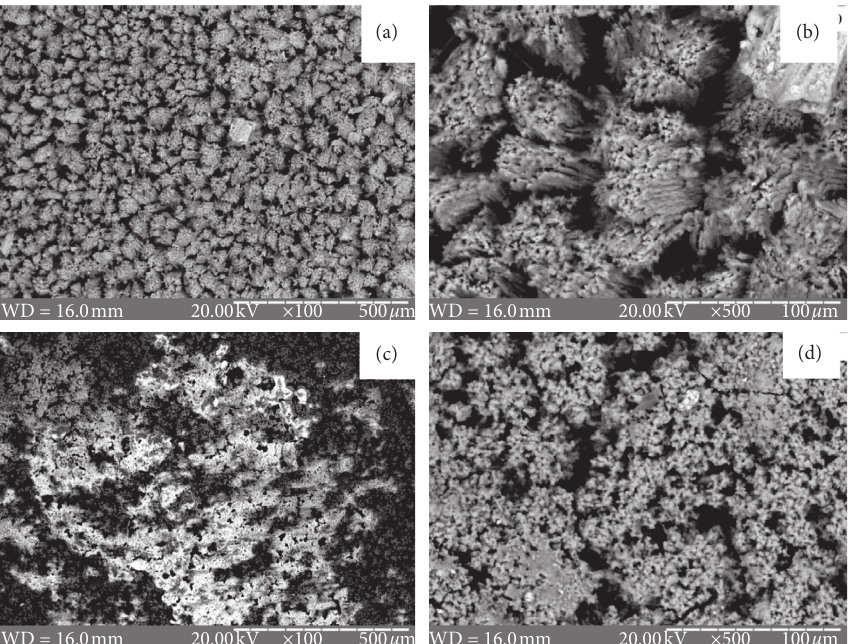
Figure 3: SEM images of steel scaled surface after 150h of boiling in tap water with addition: (a) blank; (b) 10mL/L of rape pomace extract; (c) 10mL/L of radish cake extract; (d) 10mL/L of sugar beet pulp